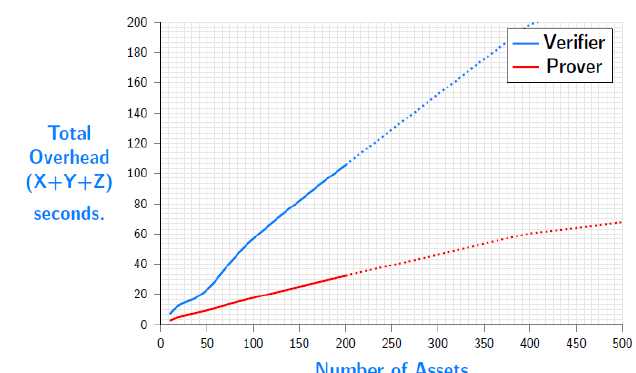
Table 2: Constraints System Data in Zokrates Assets